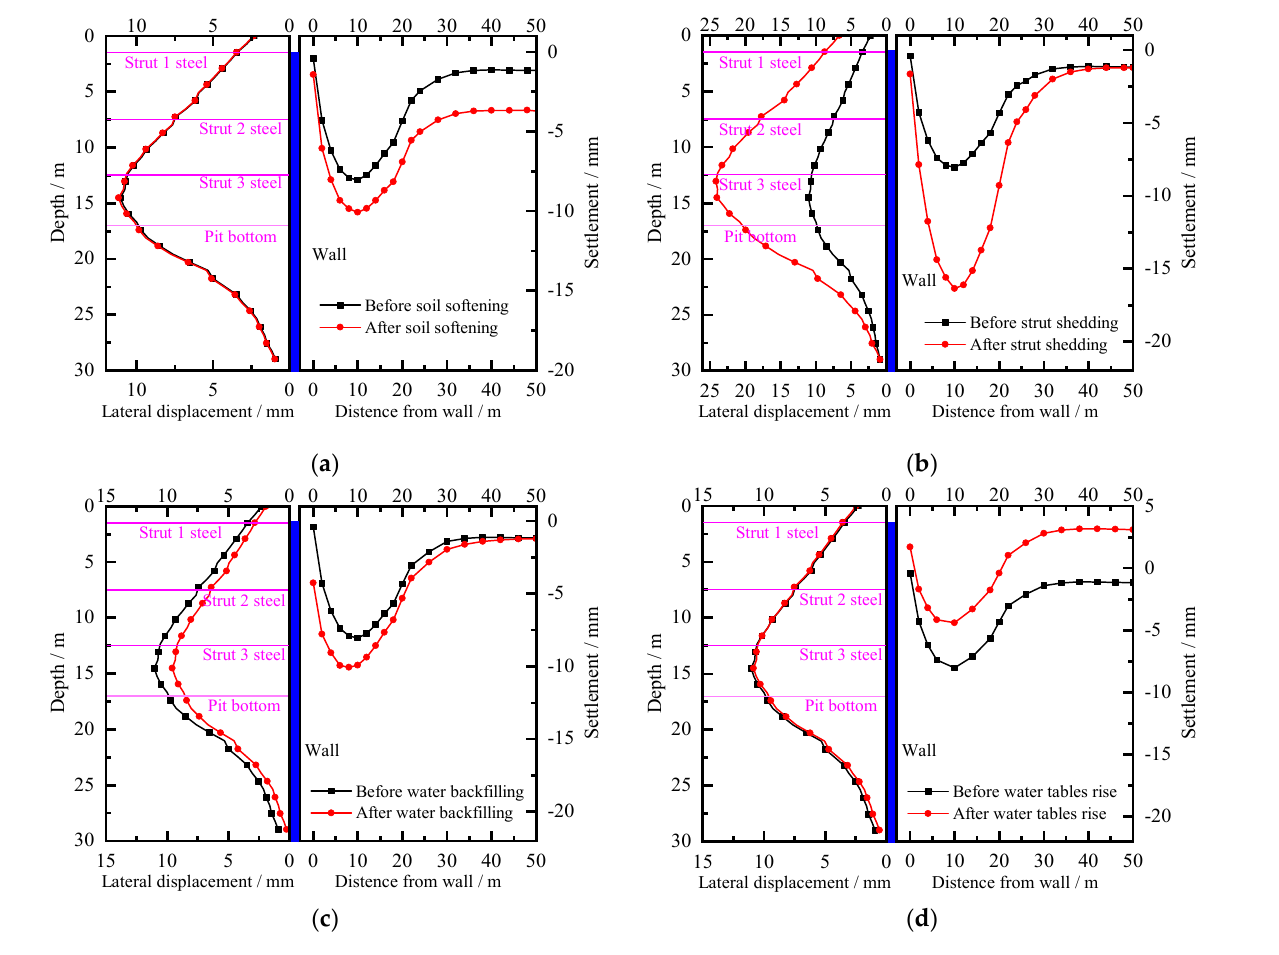
Figure 9. Results of the numerical model calculation. ( a ) Lateral displacement of the wall and ground surface settlement before and after soil softening; ( b ) lateral displacement of the wall and ground surface settlement before and after steel strut shedding; ( c ) lateral displacement of the wall and surface settlement before and after water backfilling in the foundation pit; ( d ) lateral displacement of the wall and surface settlement before and after the rise in the groundwater